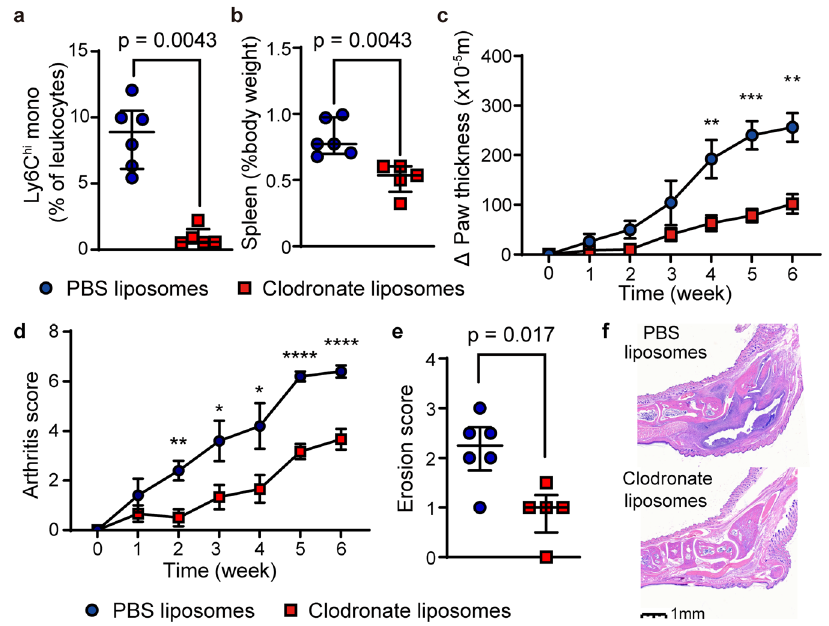
Fig. 4 | Phagocyte depletion reduces arthritis severity and bone erosion in IL1rn − / − mice. a Peripheral blood monocyte count, ( b ) spleen size, ( c ) ankle joint thickness, ( d ) composite arthritis score, ( e ) bone erosion score (micro-CT) and ( f ) representative depiction of joint histology in IL1rn − / − mice treated with PBS- liposomes ( n =6) or clodronate-liposomes ( n =5) for 6 weeks. Data in ( a , b , d , e , f ) were pooled from 2 independent experiments. Mice were 6 weeks old for